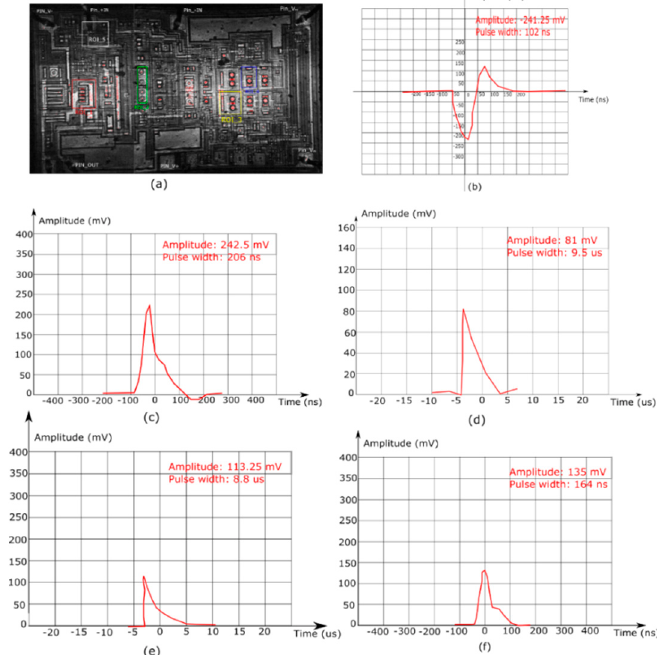
Figure 15. SET results in each ROI. ( a ) distribution of ROIs; ( b ) SET pulse in ROI_1; ( c ) SET pulse in ROI_2; ( d ) SET pulse in ROI_3; ( e ) SET pulse in ROI_4; ( f ) SET pulse in ROI_5.